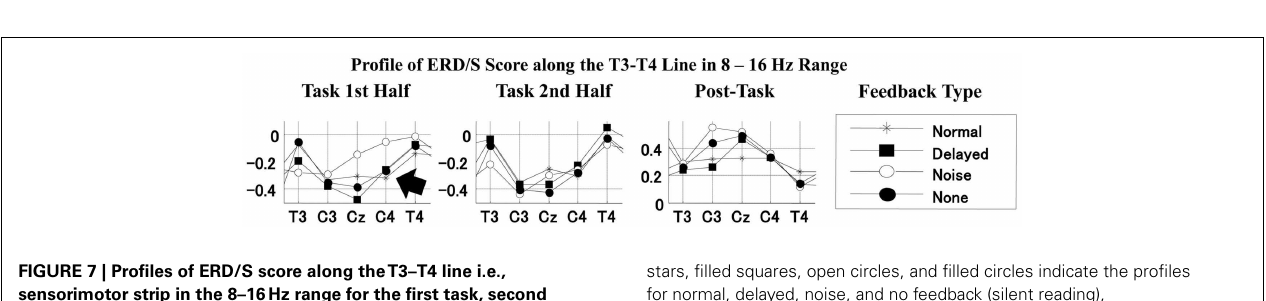
FIGURE 6 |The p -value of the t -statistics is shown at each recording site with gray scale: black, gray, light gray, and white indicate p < 0.001, p < 0.05, p < 0.1, and p > 0.1, respectively (see also Figure 5).